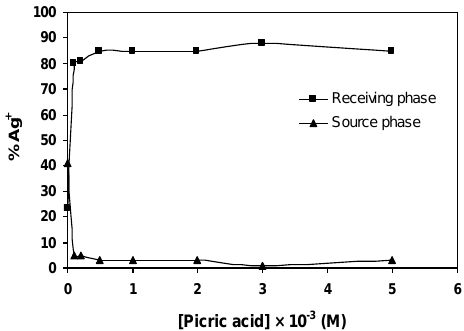
Figure 2. Effect of picric acid concentration on Ag + cation transport. Experimental conditions: source phase, 10 ml of 3.0×10 -4 M Ag + cation and varying concentration of picric acid at pH 4; liquid membrane phase, 50 ml of 1.0×10 -3 M carrier in DCM; receiving phase, 5 ml of 1.0×10 -3 M S O 32- at pH 3; time of transport, 4 2